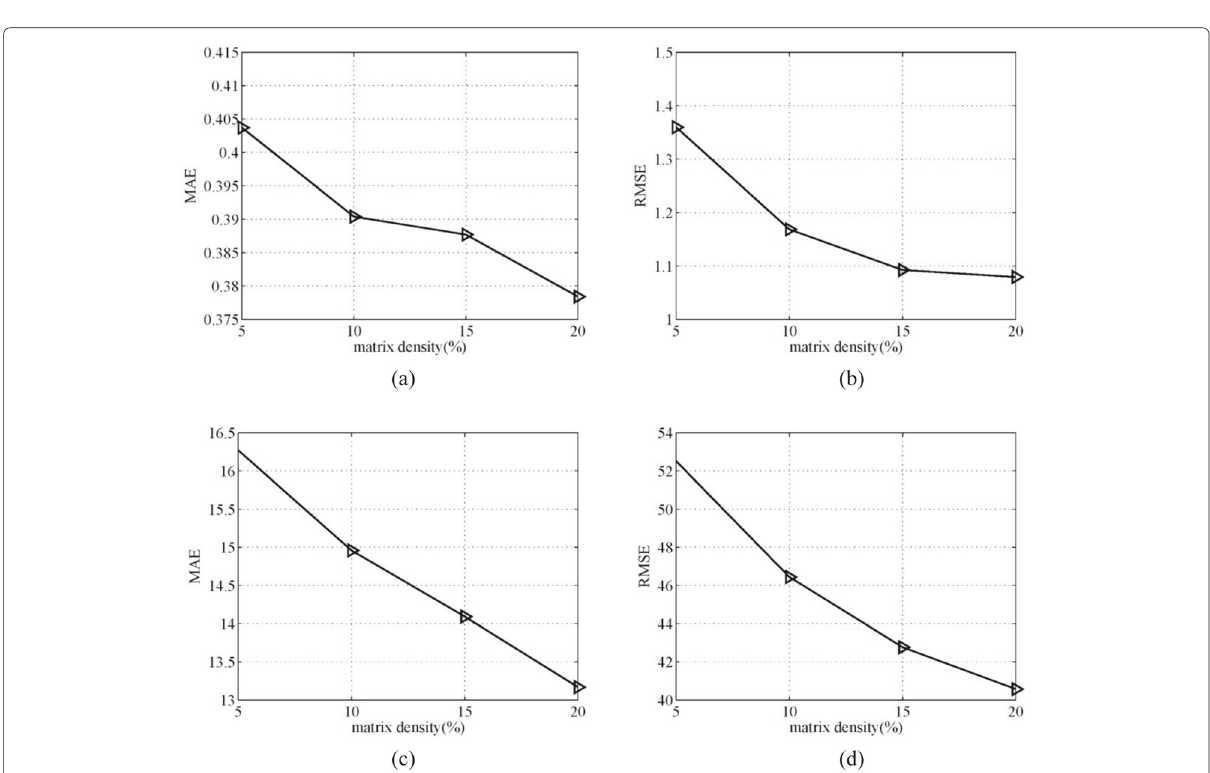
Fig. 2 Impact of matrix density on prediction